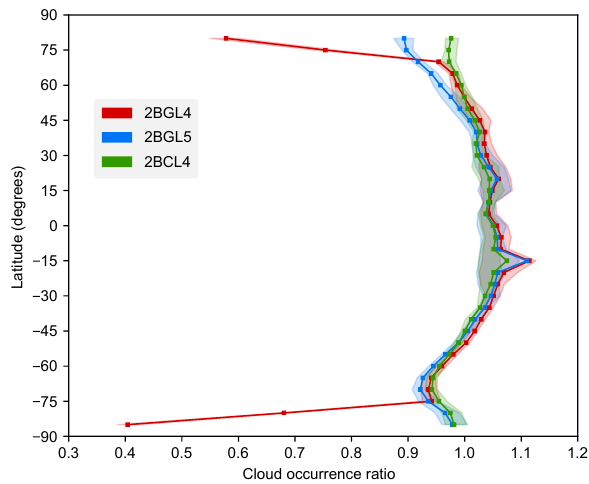
Figure 3. Latitudinal variation of the ratio of cloud occur- rence at 8.3km to cloud occurrence at 8.0km derived from the 2B-GEOPROF-LIDAR products and the 2B-CLDCLASS-LIDAR products. The envelopes represent the interquartile ranges of the ra- tio observed at that latitude. Note that consistently anomalous val- ues (cid:28) 1 are confined to the polar